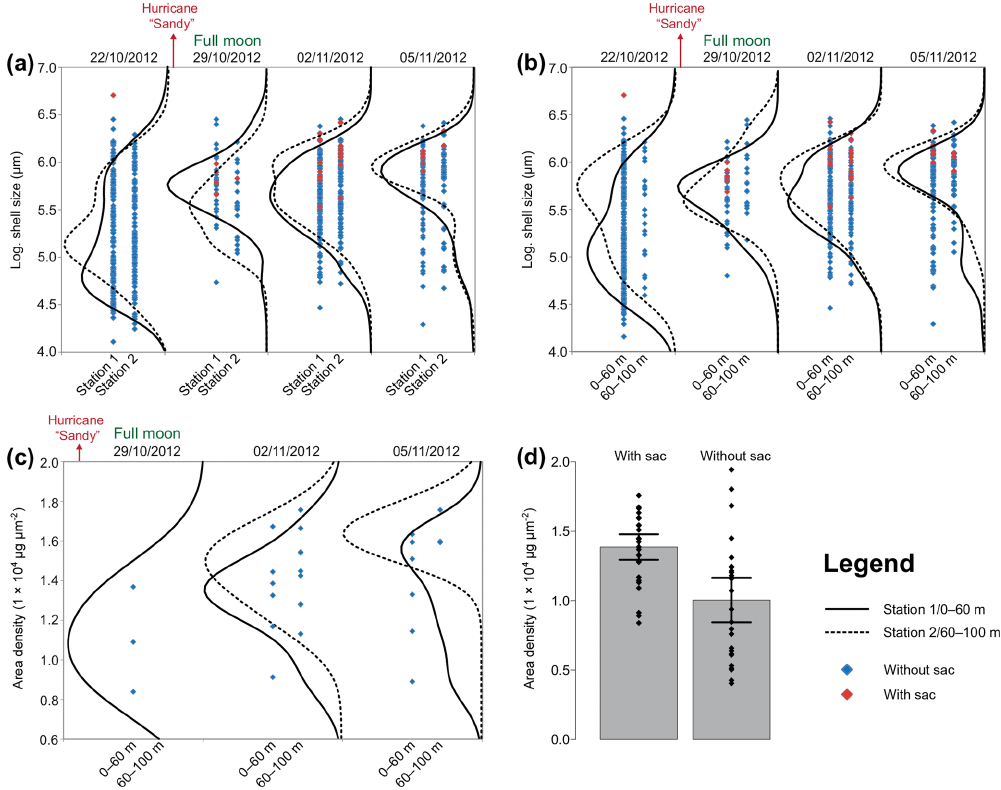
Figure 7. Size and area density changes of Trilobatus sacculifer in autumn 2012. The data are log-transformed (a, b) across the sampling period in 2012 at stations 1 and 2 and different depth intervals. A full moon occurred on the second sampling day, 29 October 2012. Hurricane Sandy passed the Greater Antilles in late October 2012. (a) Logarithmic sizes of T. sacculifer (red symbols indicate individuals with a sac-like chamber, and blue symbols indicate individuals without a sac-like chamber) at two different stations (1 and 2), pooled over the complete depth range from 0 to 100m. Black lines show kernel density distributions of sizes at station 1 (solid) and station 2 (dashed). (b) Logarithmic sizes of T. sacculifer (red symbols indicate individuals with a sac-like chamber and blue symbols indicate individuals without a sac-like chamber) at two different depth intervals, pooled over stations 1 and 2. Black lines show kernel density distributions for depth of 0–60m (solid) and depth 60–100m (dashed). (c) Area density (AD) of T. sacculifer (with sac-like chamber) along the sampling period sampled at two different depth intervals, pooled over stations 1 and 2. Black lines show kernel density distributions of weights at a depth of 0–60m (solid) and at a depth of 60–100m (dashed). (d) Comparison of AD between T. sacculifer with sac-like chamber and without sac-like chamber. Grey bars depict the mean AD including 95% confidence interval as error